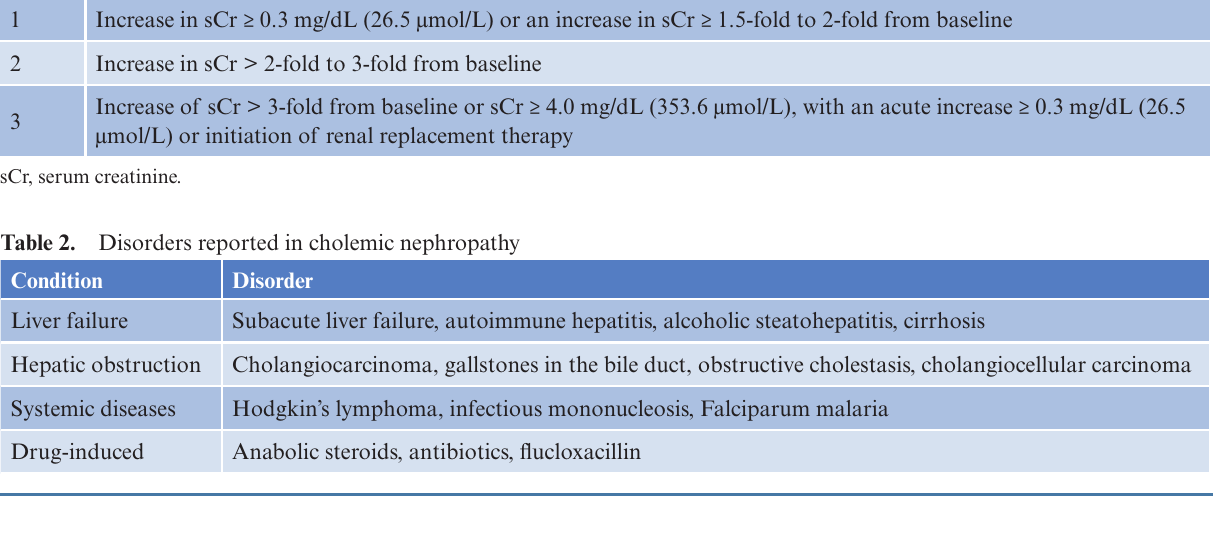
Table 1. Definition of AKI in patients with cirrhosis Stage